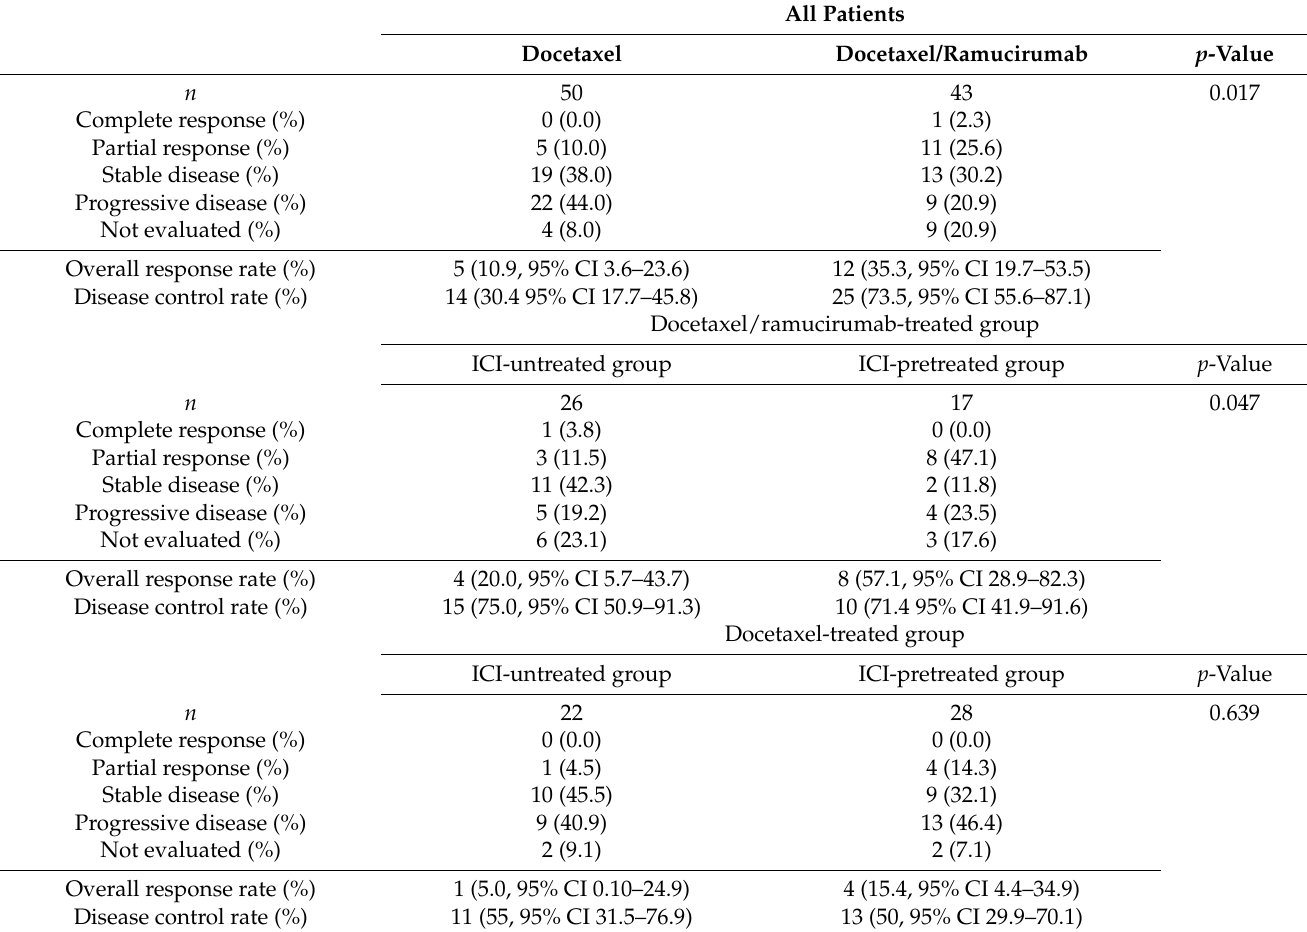
Table 2. Tumor response rate and disease control